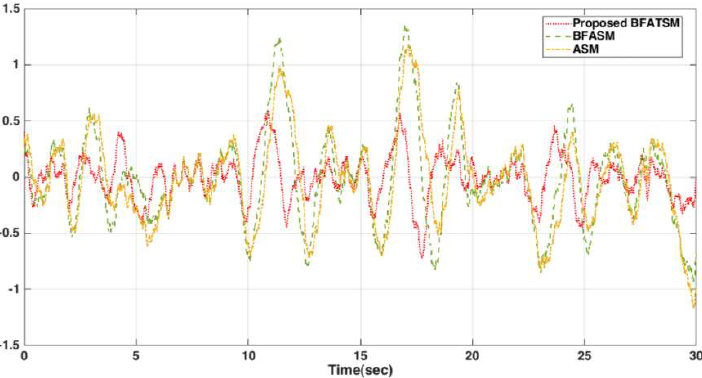
Figure 7. Simulation results for sliding surface variable in ASM controller [1] compared to BFATSM controller [2].